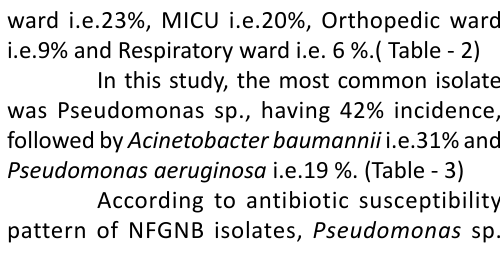
Table 2. Department/ Unit wise distribution of isolates